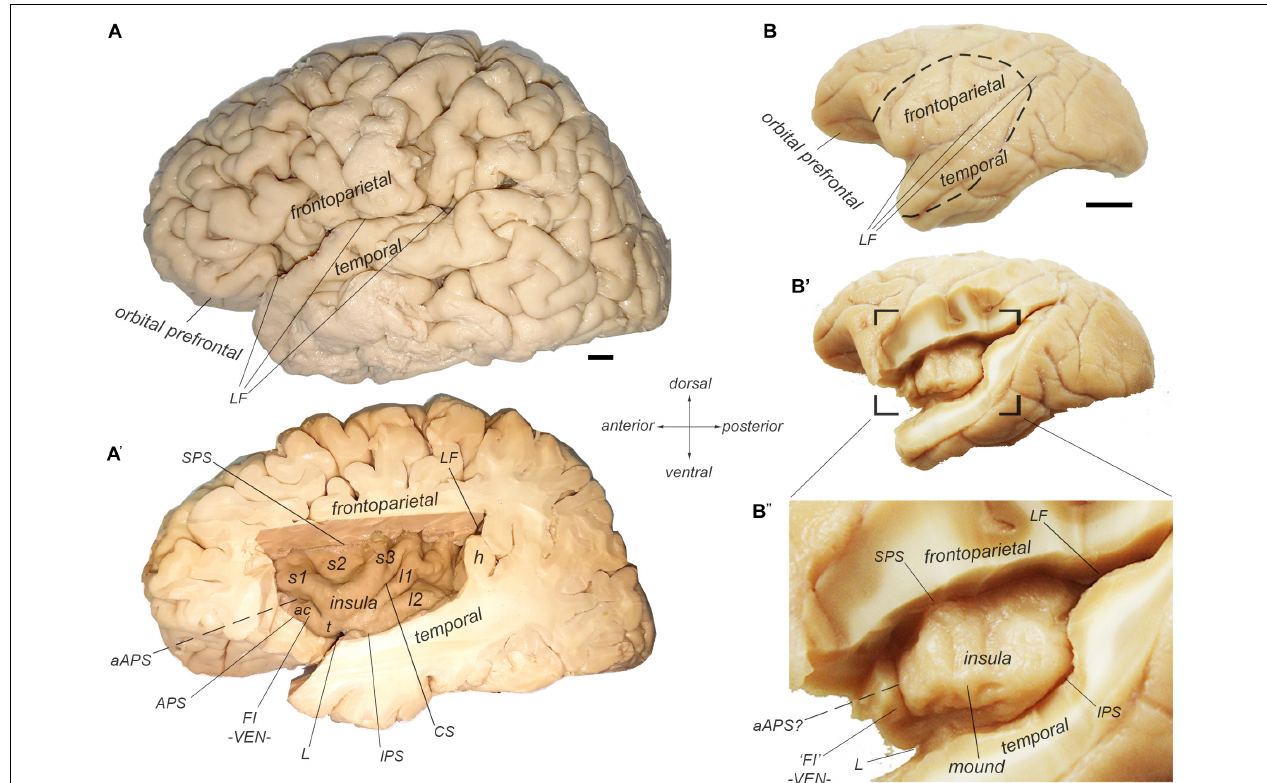
FIGURE 1 | Morphological delineation of the insula and its main structural landmarks in the human and cynomolgus macaque monkey brains. (A , A’) Photographs of the lateral (left) aspect of a human brain with (A) and without (A’) the frontoparietal and temporal opercula that cover the insular cortex, which is located in the depth of the LF. The human insula contains two posterior long posterior gyri (l1 and l2) separated from three anterior short gyri (s1-3) by the central sulcus of the insula (CS). The anterior insula contains an additional accessory short gyrus, which varies in size and demarcation. We consider that this accessory gyrus overlaps with the so-called FI, which is characterized by its high concentration of von Economo neurons (VEN). The insula is delimited by the superior (SPS), inferior (IPS), and anterior (APS) peri-insular sulci. “h” denotes one of the temporal gyri of Heschl. (B – B”) Photographs of the lateral (left) aspect of a cynomolgus macaque monkey brain with (B) and without (B’ , B”) the frontoparietal and temporal opercula that cover the insular cortex, which is located in the depth of the LF. The macaque insula is essentially smooth with an incipient ventral gyrus or “mound” and a shallow, but distinct anterior sulci or “ridge,” which marks the limit of the anterior insular region containing the VEN, and which we consider a structural homolog of the human